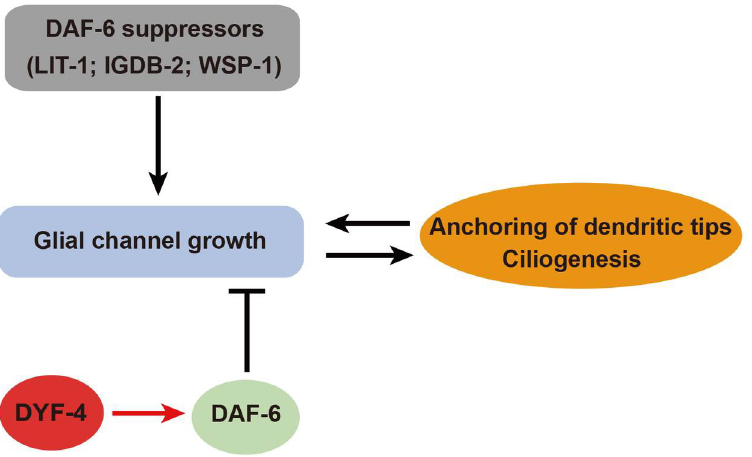
Fig 8. A model for the role of DYF-4 and DAF-6 in sensory compartment morphogenesis. The glial channel morphogenesis coordinates with the dendrite tip anchoring and ciliogenesis. DAF-6 restricts glial channel growth, while suppressors of daf-6 promote it [12]. DYF-4 regulates the function of DAF-6, which in turn restricts the expansion of glia channel.